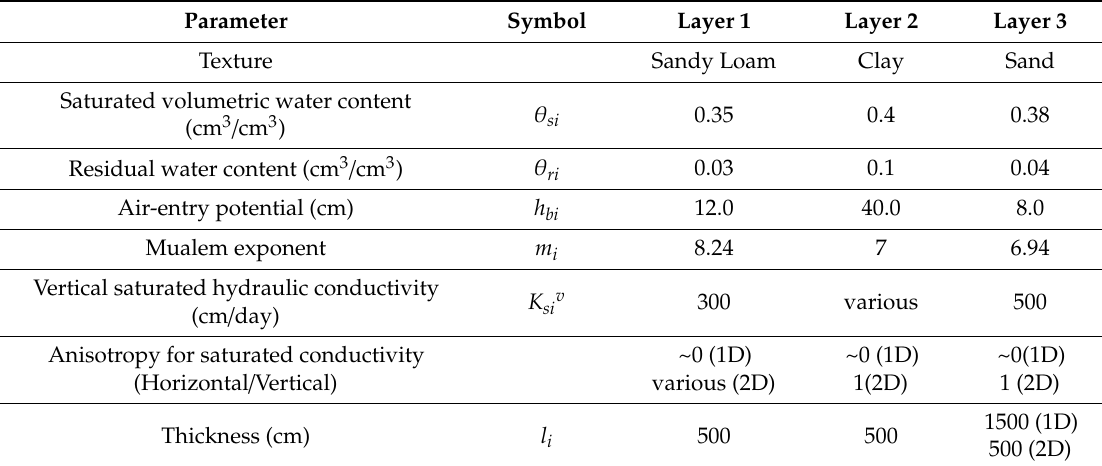
Table 2. Default soil parameters used in the